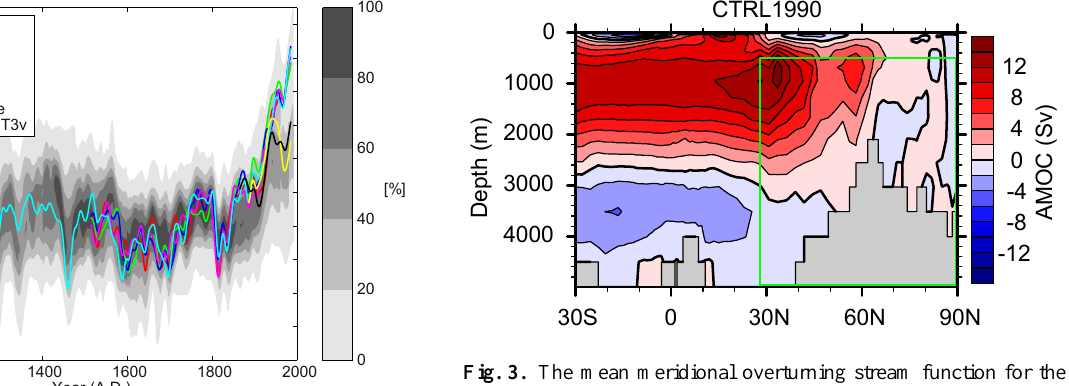
Fig. 3. The mean meridional overturning stream function for the Atlantic basin in the CTRL1990 experiment. Positive values indi- cate anticyclonic circulation. The AMOC index is defined as the maximum value of the stream function inside the green box (28 ◦ N to 90 ◦ N, below of 500m). Table 2. Standard deviations (Stdd) of the AMOC index for the annual mean, the low-pass filtered ( > 30 yrs.) and the high-pass filtered ( < 30 yrs.) time